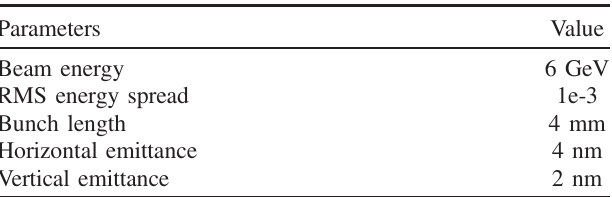
TABLE III. Parameters of the injected beam used in the following ELEGANT simulation.